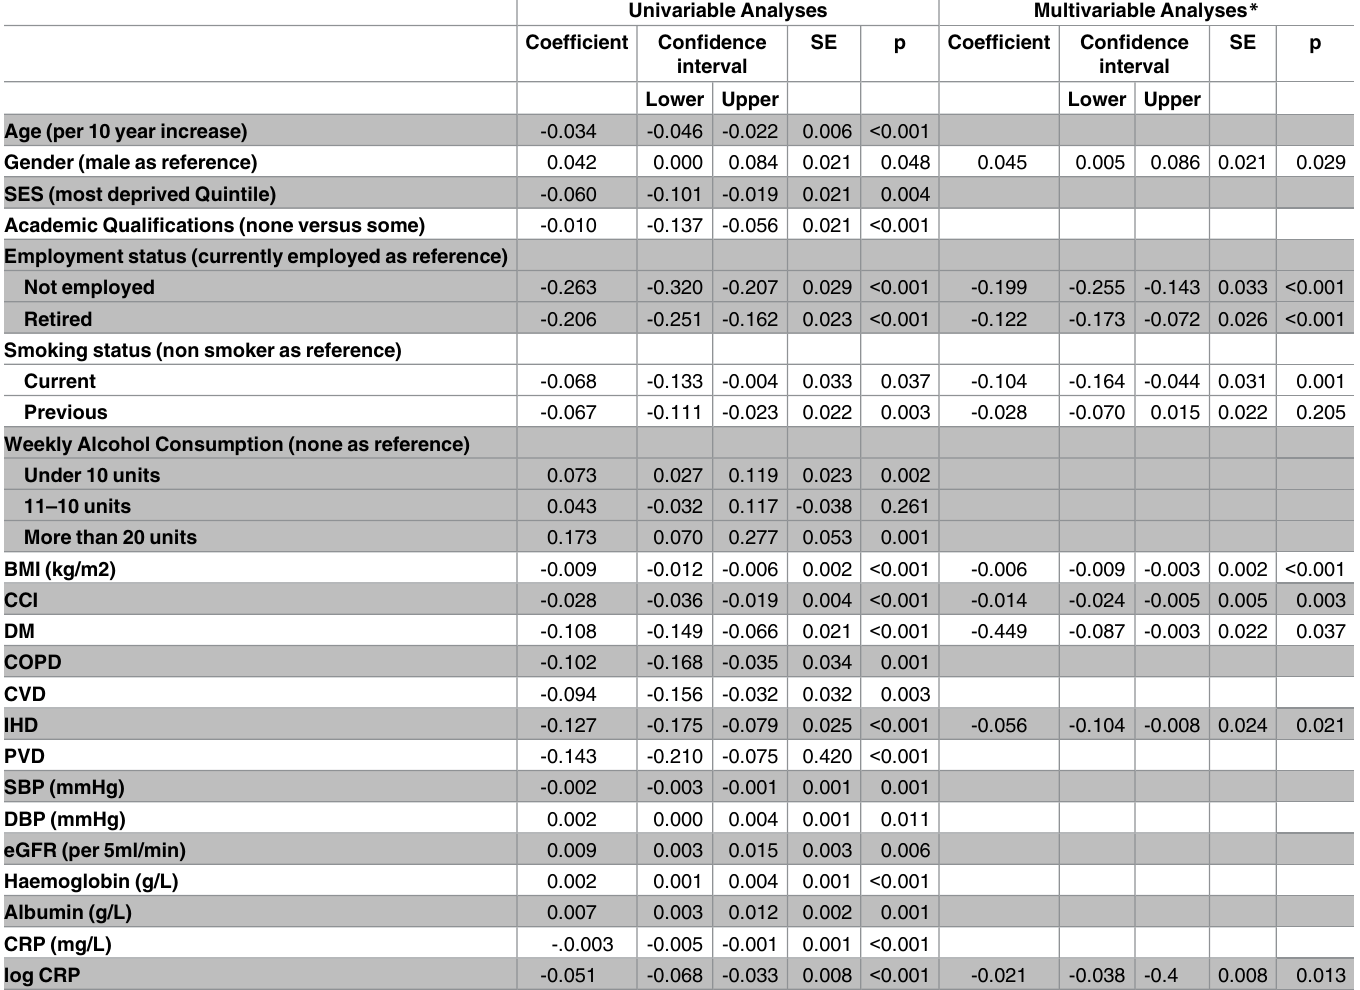
Table 8. Variables predictive of higher EQ-5D index score by linear